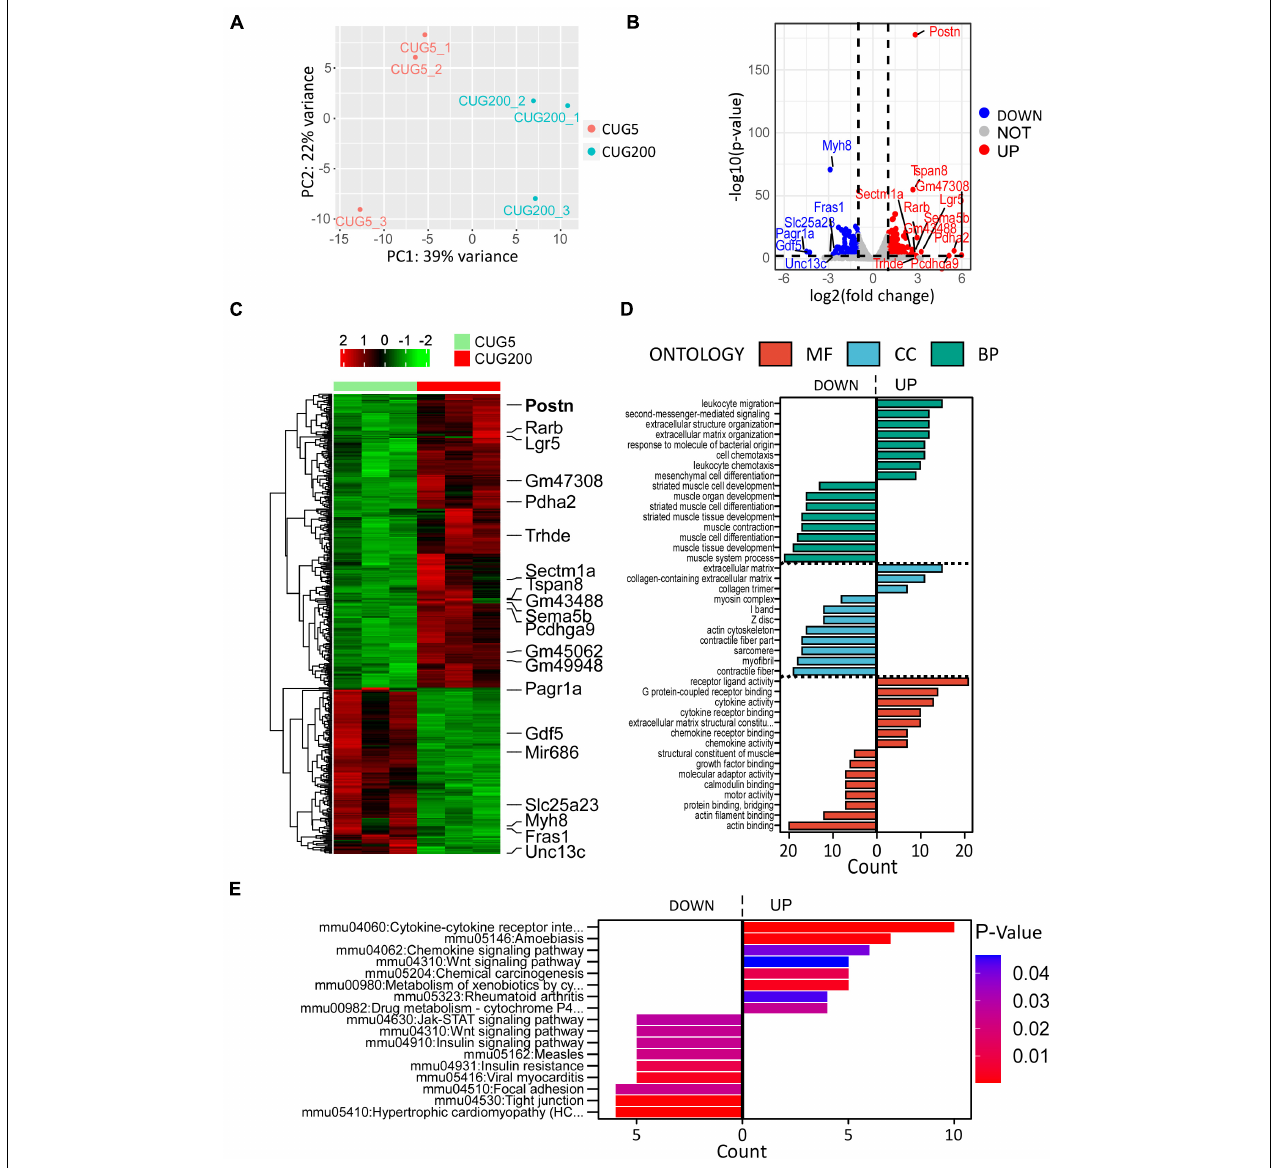
FIGURE 2 | Periostin ( Postn ) was the top significantly altered gene in DM1 myoblast differentiation compared with the normal control. (A) Principal components analysis (PCA) of RNA sequencing (RNA-seq) data from normal and DM1 groups. Three biological replicates are included for each group. (B) Volcano plot showing the differentially expressed genes (DEGs). Postn was the top significantly altered gene. (C) Heatmap showing relative levels of all DEGs in both groups. (D) Gene ontology (GO) analysis of the DEGs. (E) Kyoto Encyclopedia of Genes and Genomes (KEGG) analysis of the DEGs. CUG5, normal control myoblast cells (C2C12 GFP-CUG5); CUG200, DM1 myoblast cells (C2C12 GFP-CUG200); MF, molecular function; CC, cellular component; and BP, biological